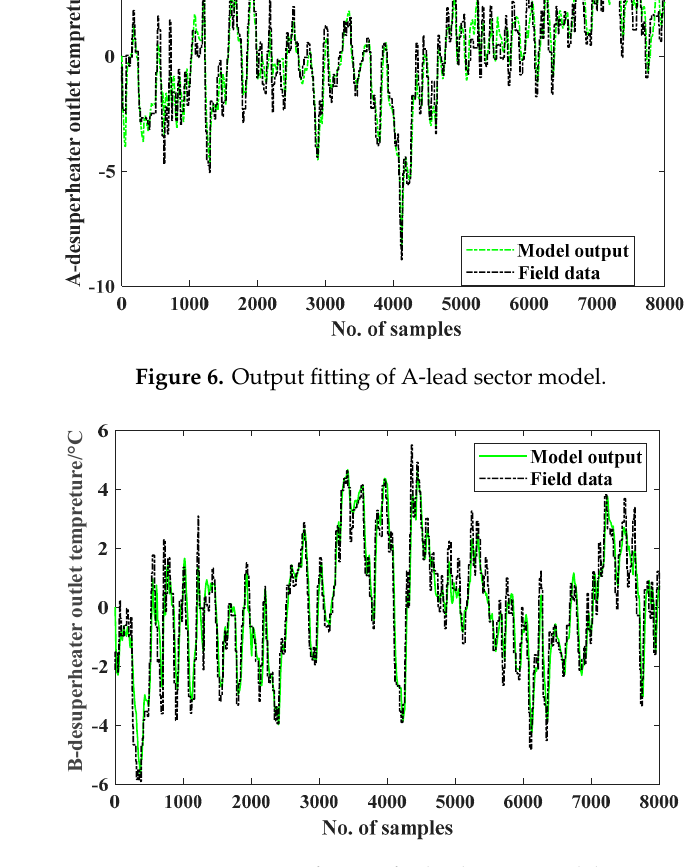
Figure 7. Output fitting of B-lead sector model.